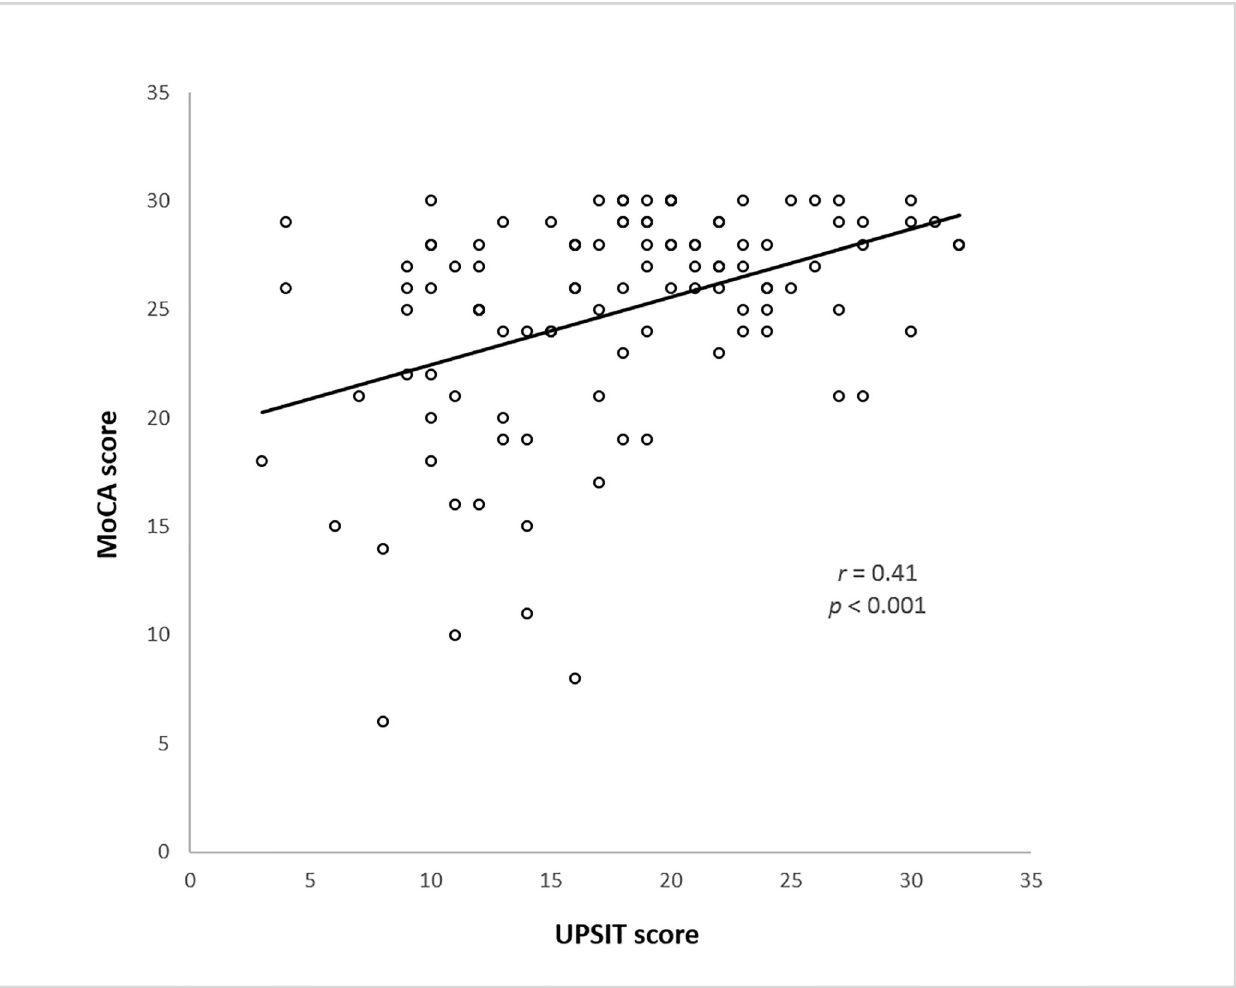
Fig 1. Correlation between MoCA and UPSIT score. r = correlation coefficient; MoCA: Montreal cognitive assessment; UPSIT: University of Pennsylvania smell identification test.